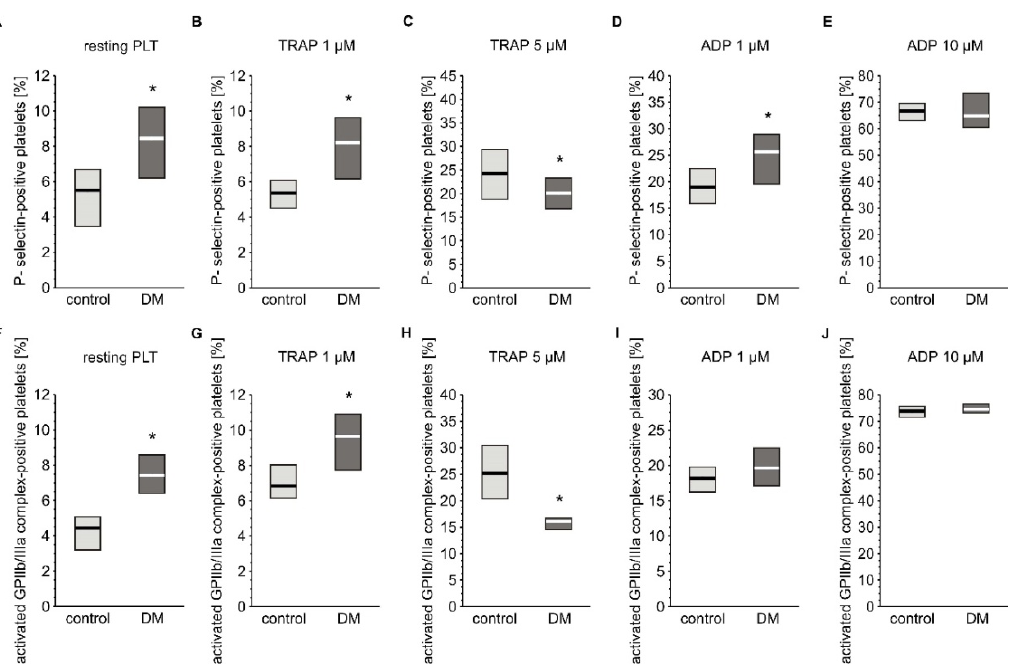
Figure 2. Expression of CD62P and the active form of GPIIb / IIIa on platelets from type 2 diabetic patients. Results are presented as median (vertical line) and interquartile range (box) ( n = 35 for each group). Mean age 55.0 ± 8.1 (control) vs. 58.2 ± 7.4 (DM) (mean ± SD). The activation of circulating platelets ( A , F ) and platelets reactivity in response to 1 µ M ( B , G ) or 5 µ M TRAP ( C , H ) and 1 µ M ( D,I ) or 10 µ M ADP ( E , J ) was estimated using flow cytometry in diabetic patients and control subjects on the basis of the surface platelet expression of P-selectin ( A – E ) and the activated GPIIb / IIIa (PAC-1 binding) ( F – J ). More experimental details are given in the Materials and Methods section. The asterisk denotes the particular significances estimated with the use of one-tailed Mann–Whitney U test using bootstrap-boosted